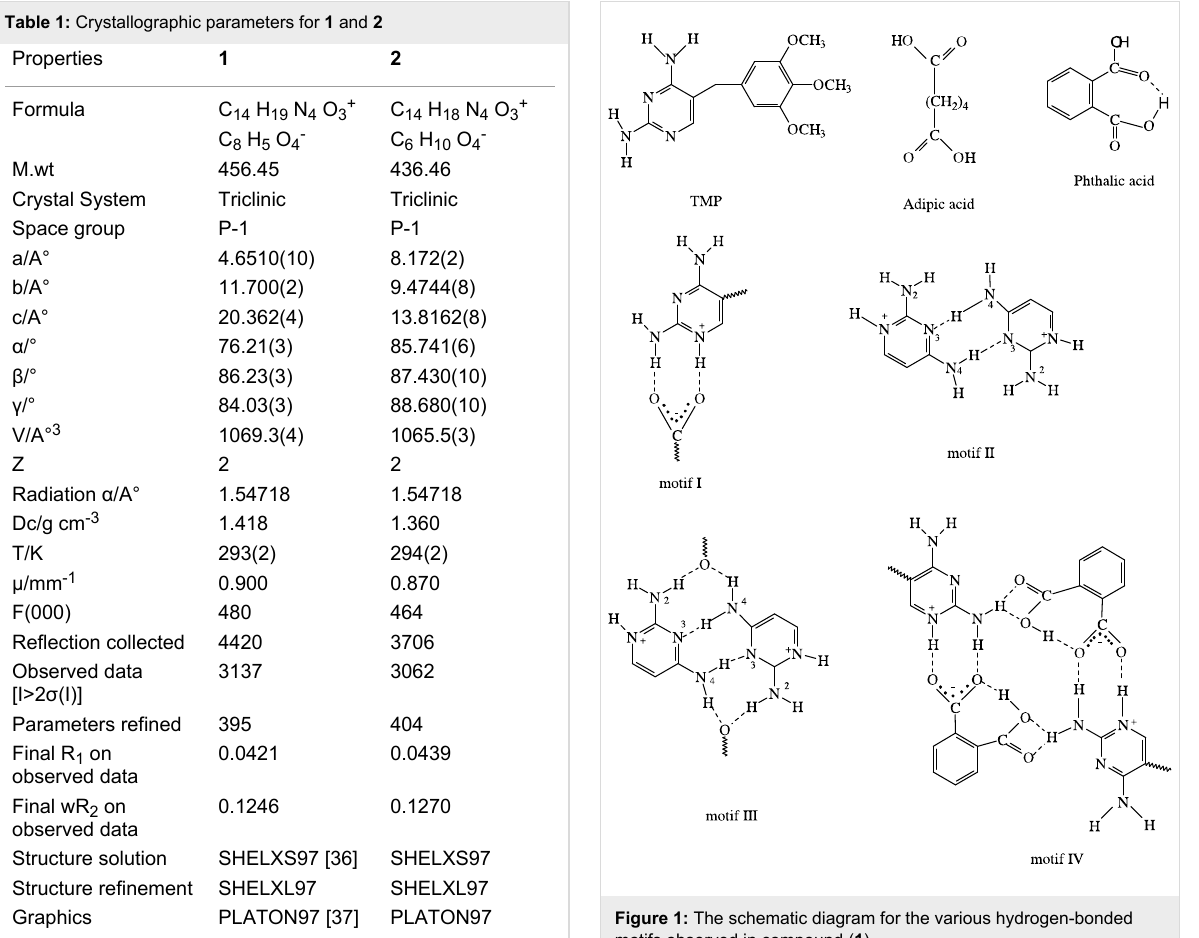
(3',4',5'-trimethoxybenzyl)pyrimidine] (TMP) is an antifolate drug. In the protonated form, it exerts its activity through the inhibition of the enzyme dihydrofolate reductase (DHFR)